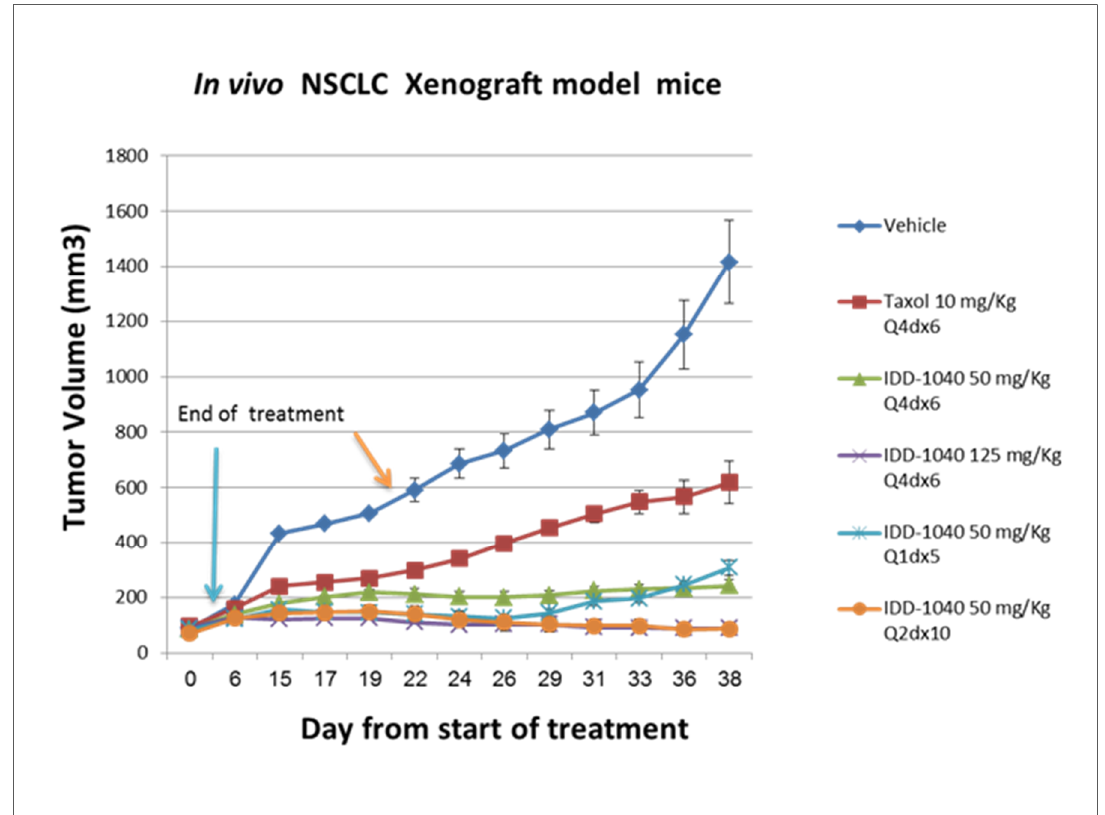
Figure 5. The effect of IDD-1040 on tumor volume in an in vivo NSCLC xenograft mouse model, given more frequently at lower dosages. Post-IV administration of vehicle (every 4 days for 24 days), Taxol (paclitaxel) (10 mg / kg every four days for 24 days), IDD-1040 (50 mg / kg and 125 mg / kg every four days for 24 days), and IDD-1040 (50 mg / kg once a day for five days, and every two days for 20 days).